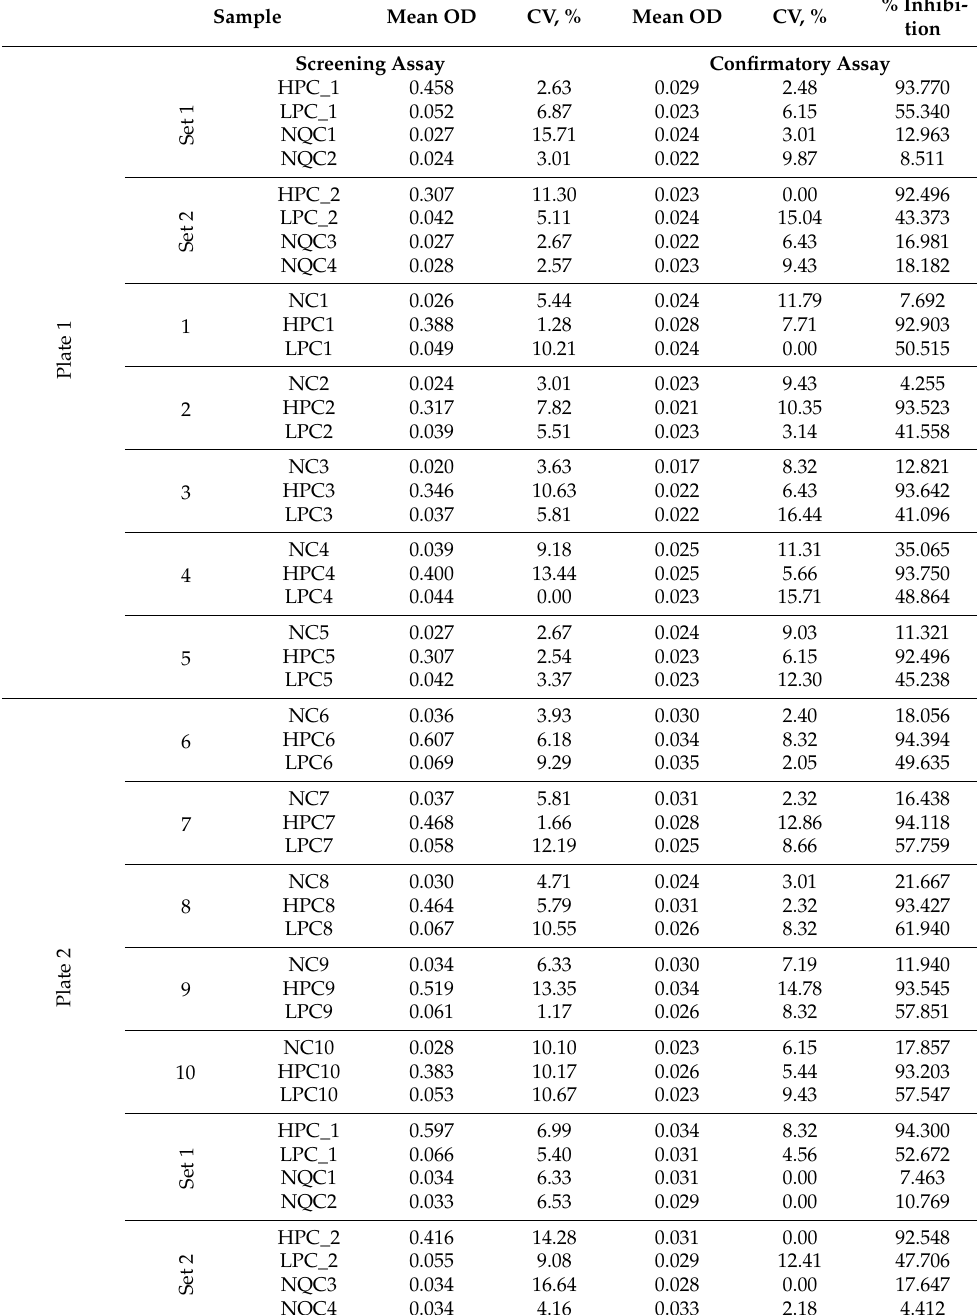
Table 6. Analytical method selectivity